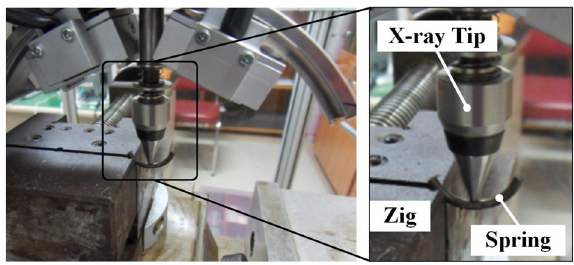
Figure 17. XRD equipment with engine valve spring specimen.